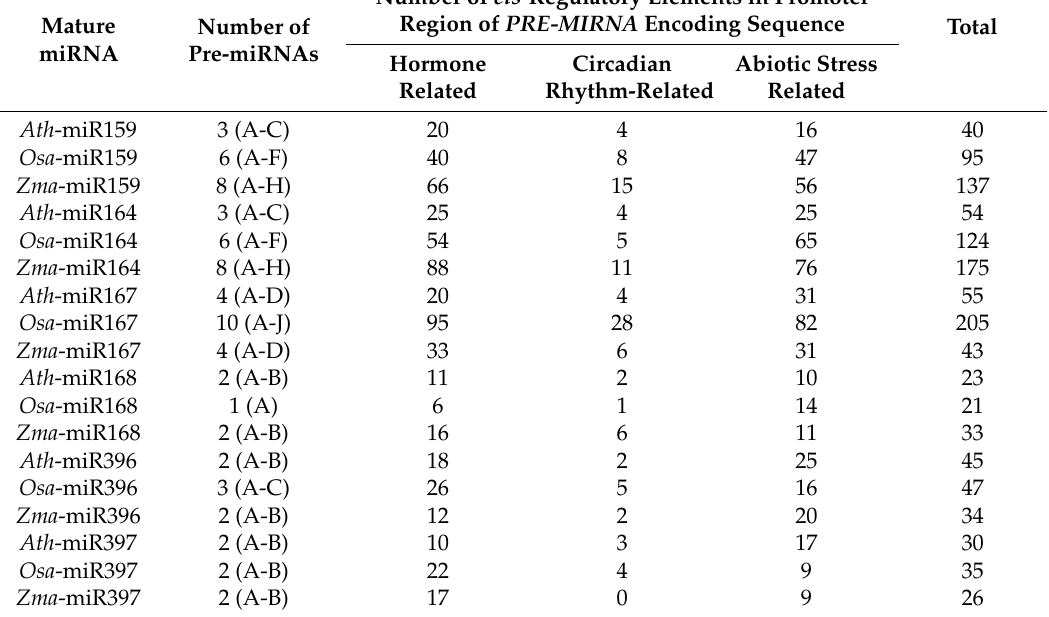
Table 1. The number of transcriptional cis -regulatory sites in MICRORNA gene promoter regions. The presence of known plant-specific cis -regulatory elements ( CREs ) were identified within the 3 kb region immediately upstream of the pre-miRNA encoding sequence (the putative promoter region of each assessed MIR gene). Only plant hormone, circadian rhythm, and abiotic stress-related CREs , were reported for the putative promoter regions of the 70 MIR genes that encode the mature miRNAs, miR159, miR164, miR167, miR168, miR396 and miR397, of maize, rice, and Arabidopsis , were included in this